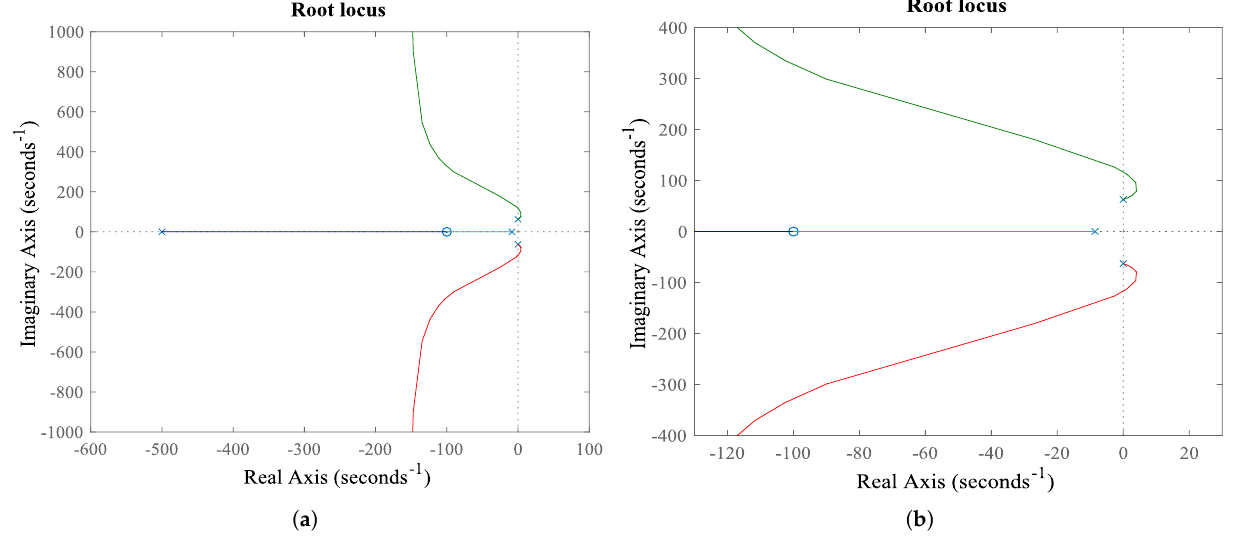
Figure 3. ( a ) Root locus plot for the internal velocity loop as a function of the gain K v ; ( b ) zoomed view of the root locus. For small values of K v , the closed-loop system poles move to the right-hand s-plane. To guarantee stability, K v should be increased beyond a lower-bound value.